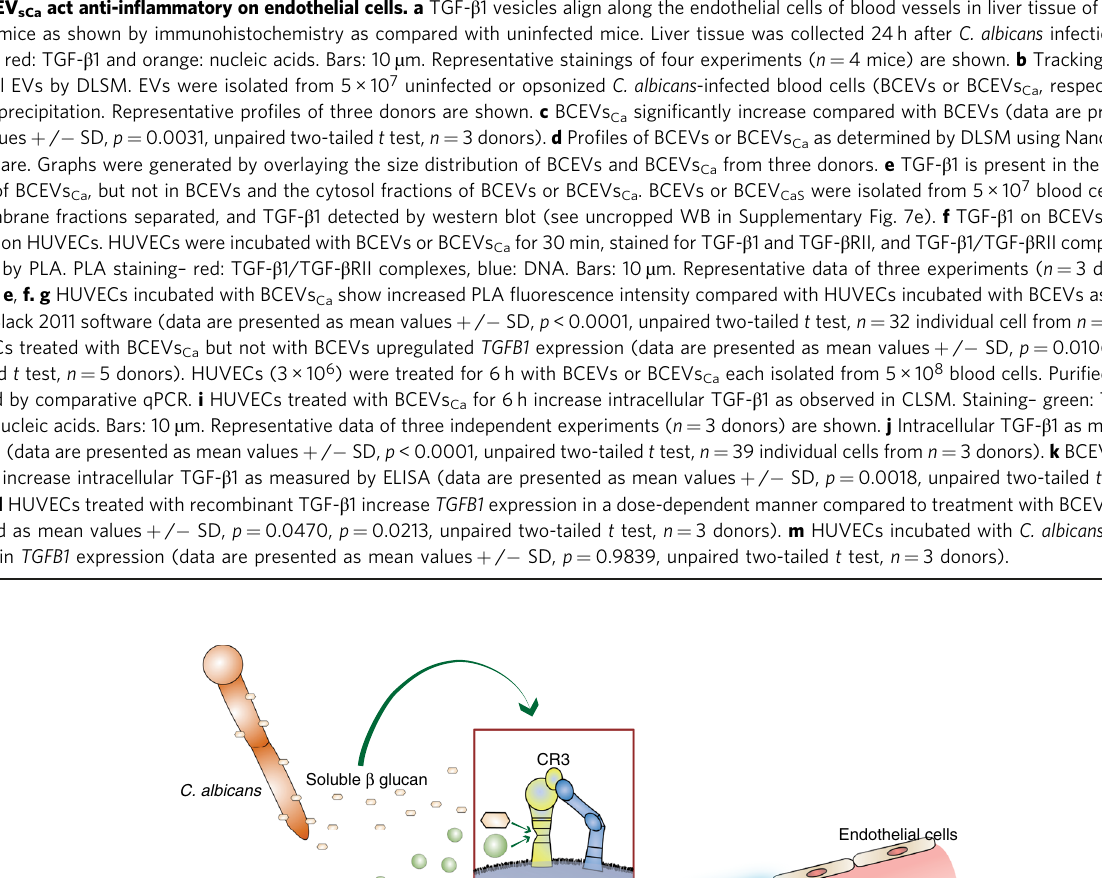
Fig. 8 TGF- β 1-transporting vesicle generation in human monocytes and modulation of the immune response. The human pathogenic fungus Candida albicans as well as human apoptotic cells induce via the complement receptor 3 on monocytes the release of TGF- β 1-transporting vesicles which act immune inhibitory and which induce synthesis of TGF- β 1 in endothelial